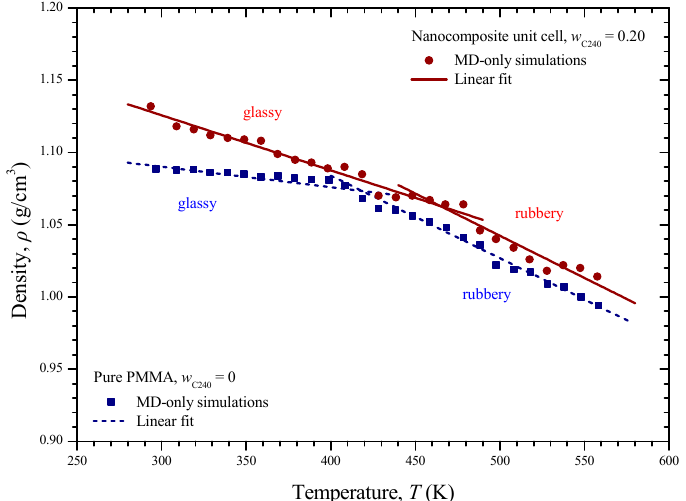
Figure 10. Density of the pure PMMA and nanocomposite with w C240 = 0.2 with respect to the temperature and corresponding linear fittings.